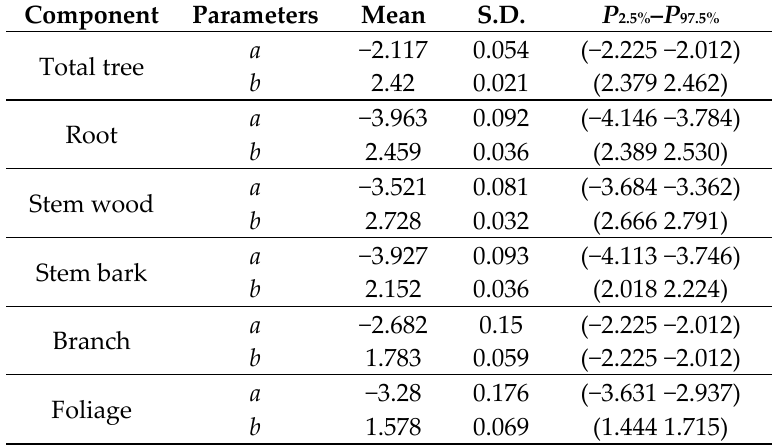
Table 4. Tree biomass model parameters using the Bayesian non-hierarchical approach.